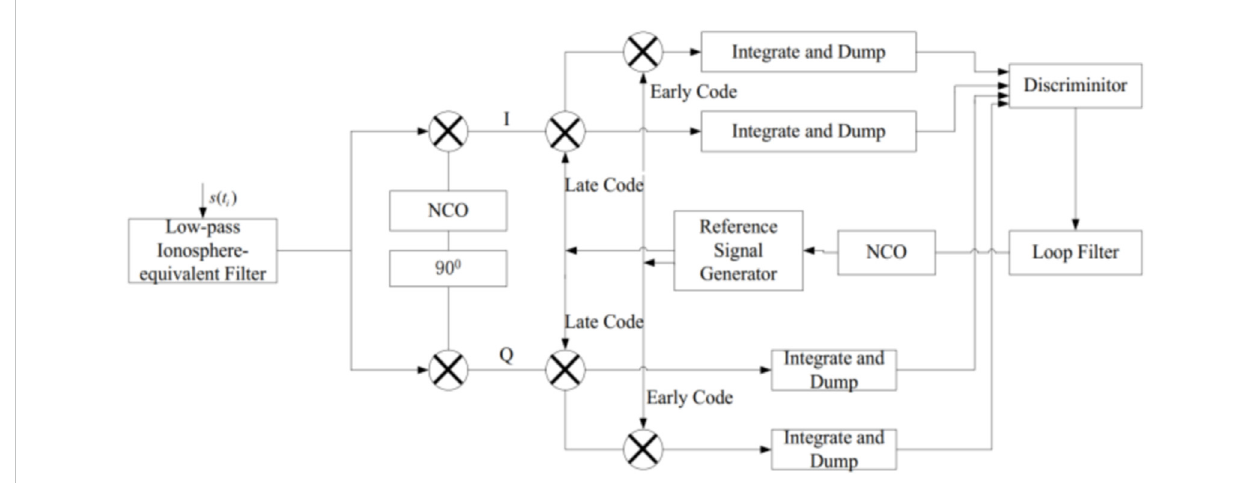
FIGURE 2 Non-coherent early-late processing (NELP) TOA estimator.